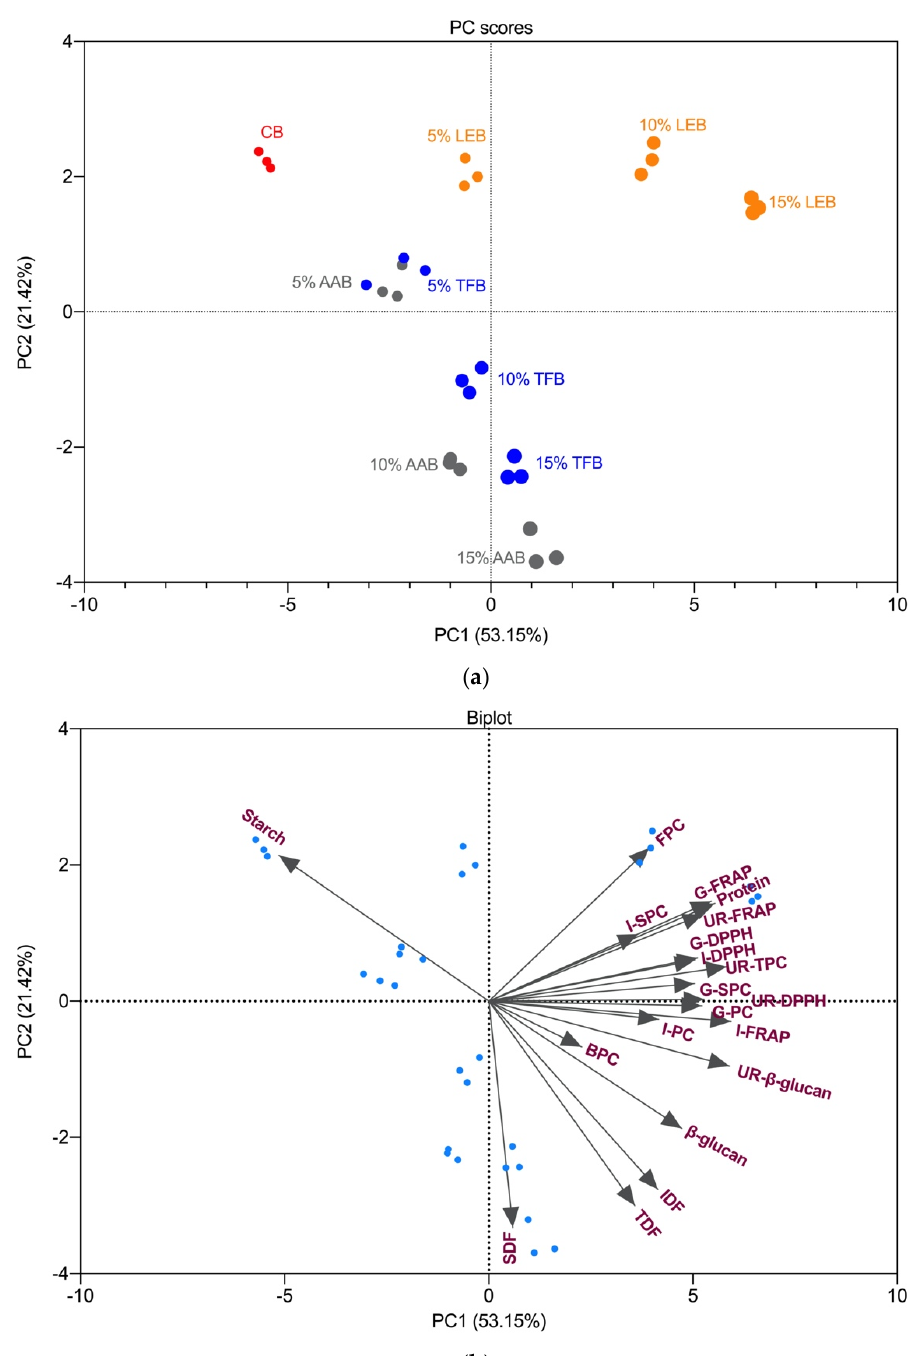
Figure 4. Principal component analysis of principal component scores biplot. PC scores distribution of different biscuit samples incorporated with dried mushrooms ( a ) and Biplot component loading ( b ) as obtained from the principal component analysis. Abbreviations: CB—control biscuits; LEB— L. edodes biscuit; AAB— A. auricula biscuit; TFB— T. fuciformis biscuit; FPC—free phenolic content biscuits; BPC—bound phenolic content of biscuits; G-PC, G-FRAP and G-DPPH represent